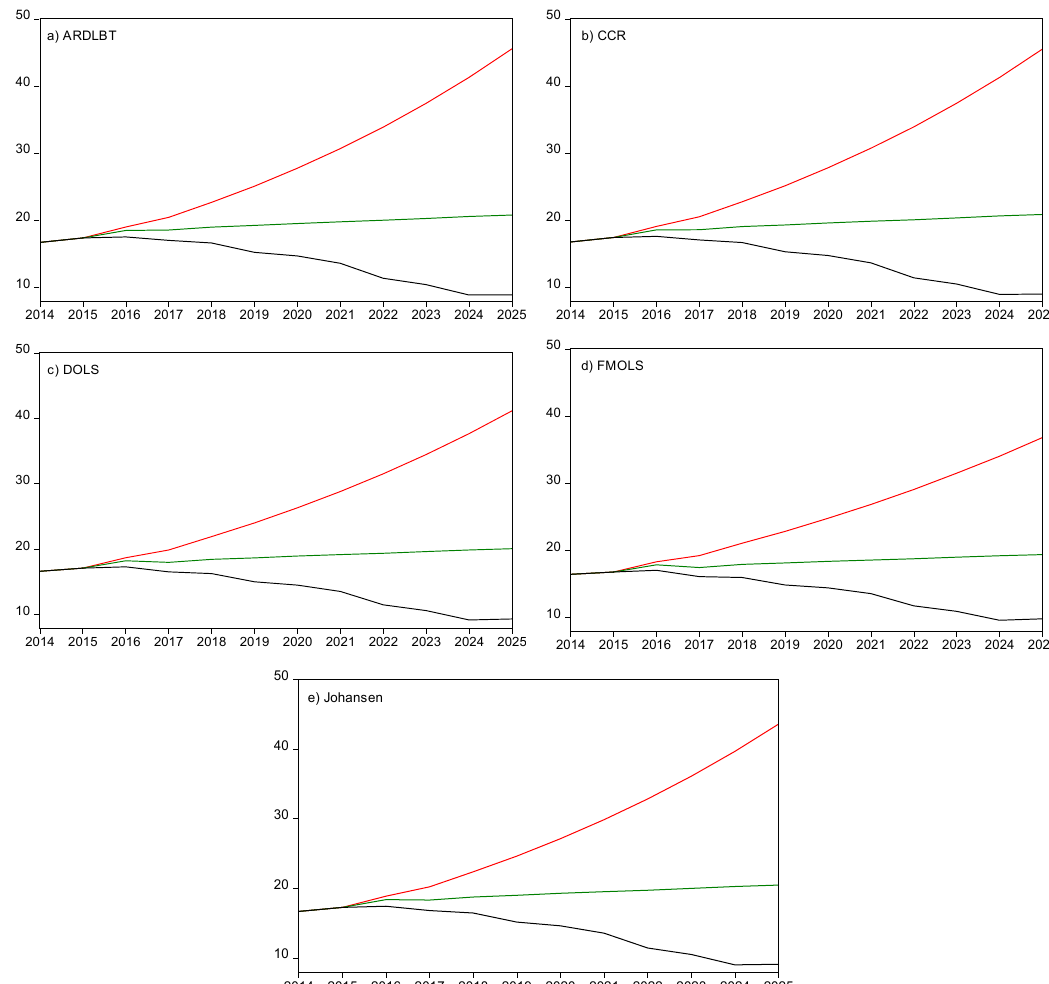
Figure 4. Projected time paths of the electricity consumption, TWh. (Note: the red, green, and grey lines indicate projected values from the “high”, Business as Usual and “low” scenarios, respectively). Energies 2016 , 9 , x